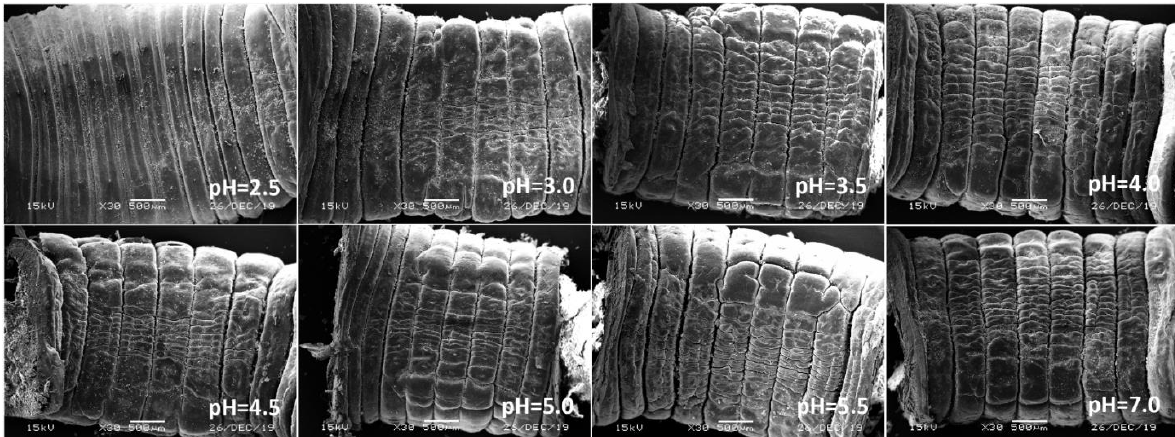
Figure 9. Ventral surface of the reproductive ring of adult Eisenia fetida in soil under acid rain with eight pH levels for 15 days ( n = 10). Treatments: pH 7.0: control, pH 2.0–5.5: acid rain with different pH levels.